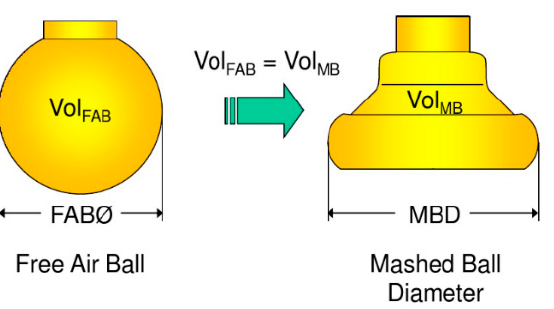
Figure 4. Comparison of the morphology of the ball bonded point before and after bonding.